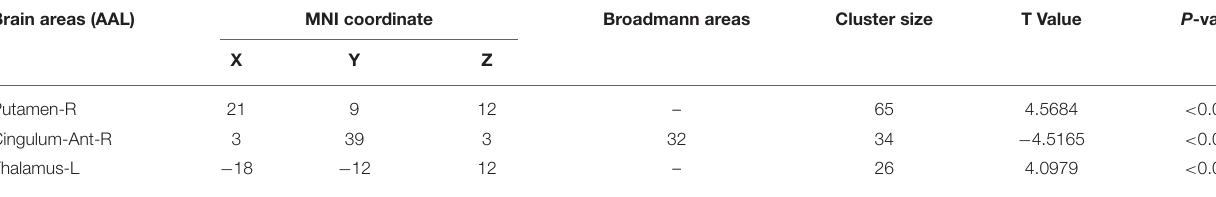
TABLE 2 | The brain areas with statistically significant differences in fALFF values between the PD-EDS and PD-NEDS group. Brain areas